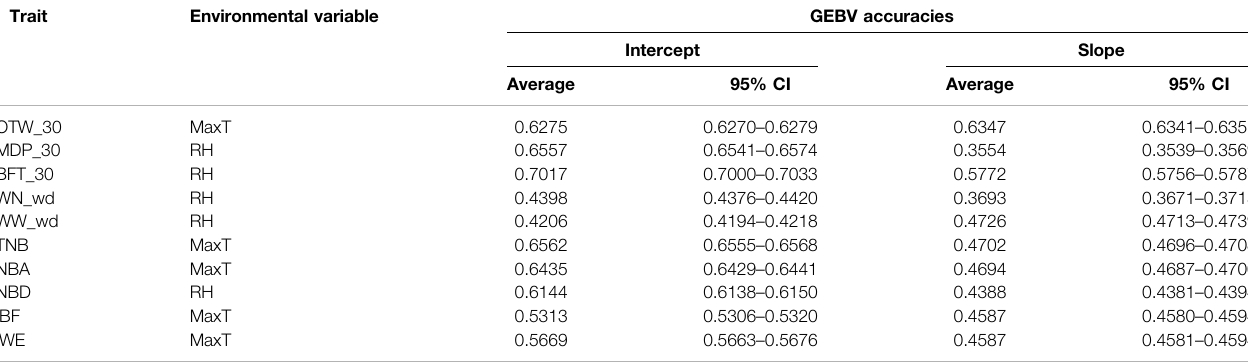
TABLE 4 | Accuracies (95% con fi dence interval) of genomic estimated breeding value for the reaction norm intercept and slope terms considering the recommended environmental variable.